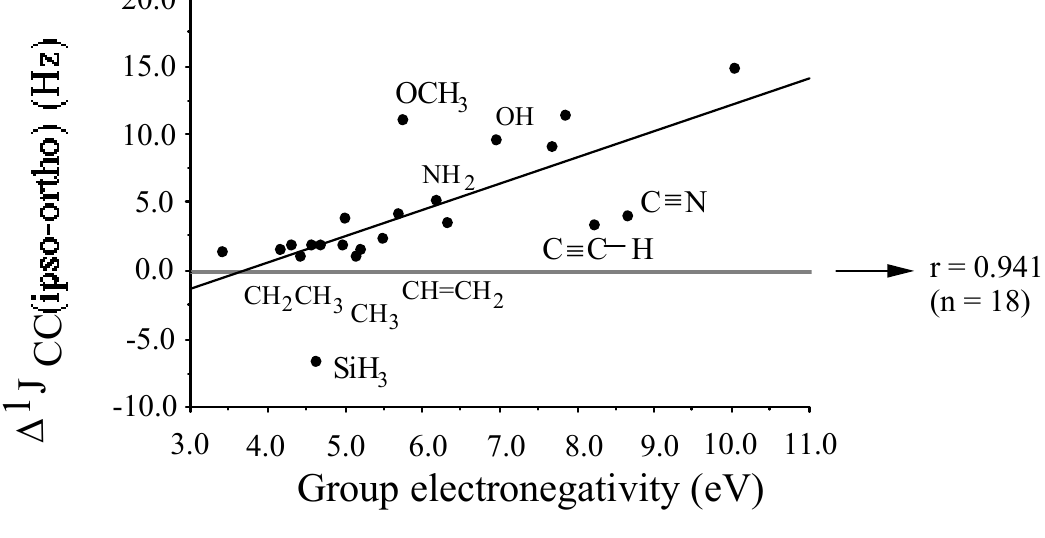
Figure 7 : Calculated vs. Experimental Group Electronegativity